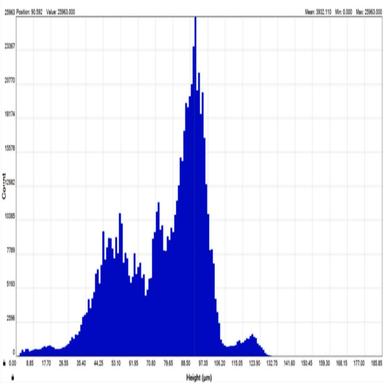
Histogram of HRFs.